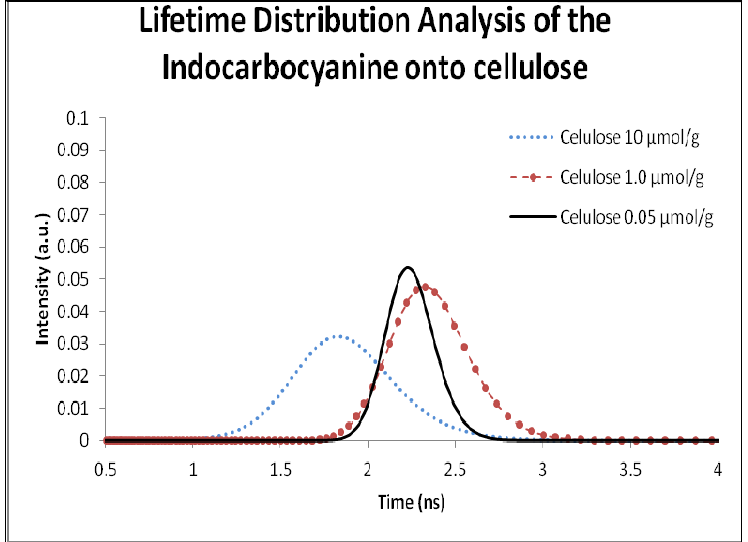
Figure 10. Lifetime distribution analysis of the 3,3'-di(2-sulfoethyl)-indocarbocyanine dye adsorbed onto microcrystalline cellulose. Samples concentration was 0.05, 1.0, 10.0 µmol of cyanine dye per gram of microcrystalline